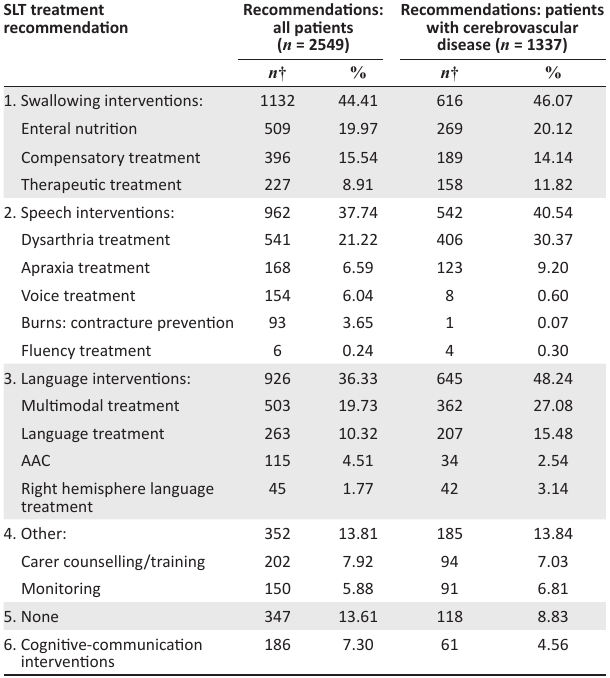
TABLE 7: Speech-language therapy treatment recommendations.